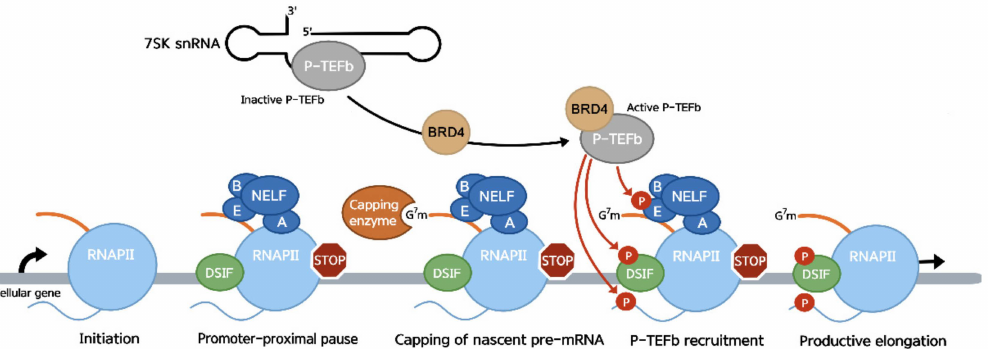
Figure 1. Transcription by RNAP II is paused after initiation as DSIF and NELF are recruited to the polymerase. This pause creates a hub for the capping enzyme, allowing the efficient capping of the nascent transcript. Interaction between P-TEFb and either BRD4 or SEC allows its activation and dissociation from the 7SK snRNP, where it is sequestered in its inactive state. The BRD4- or SEC-P- TEFb complexes are then recruited to the stalled polymerase where the kinase subunit of P-TEFb, CDK9, phosphorylates Spt5, NELF-E and the RNAP II CTD at Ser2. This leads to the dissociation of NELF from the polymerase, the transformation of DSIF into a positive elongation factor and entry into productive